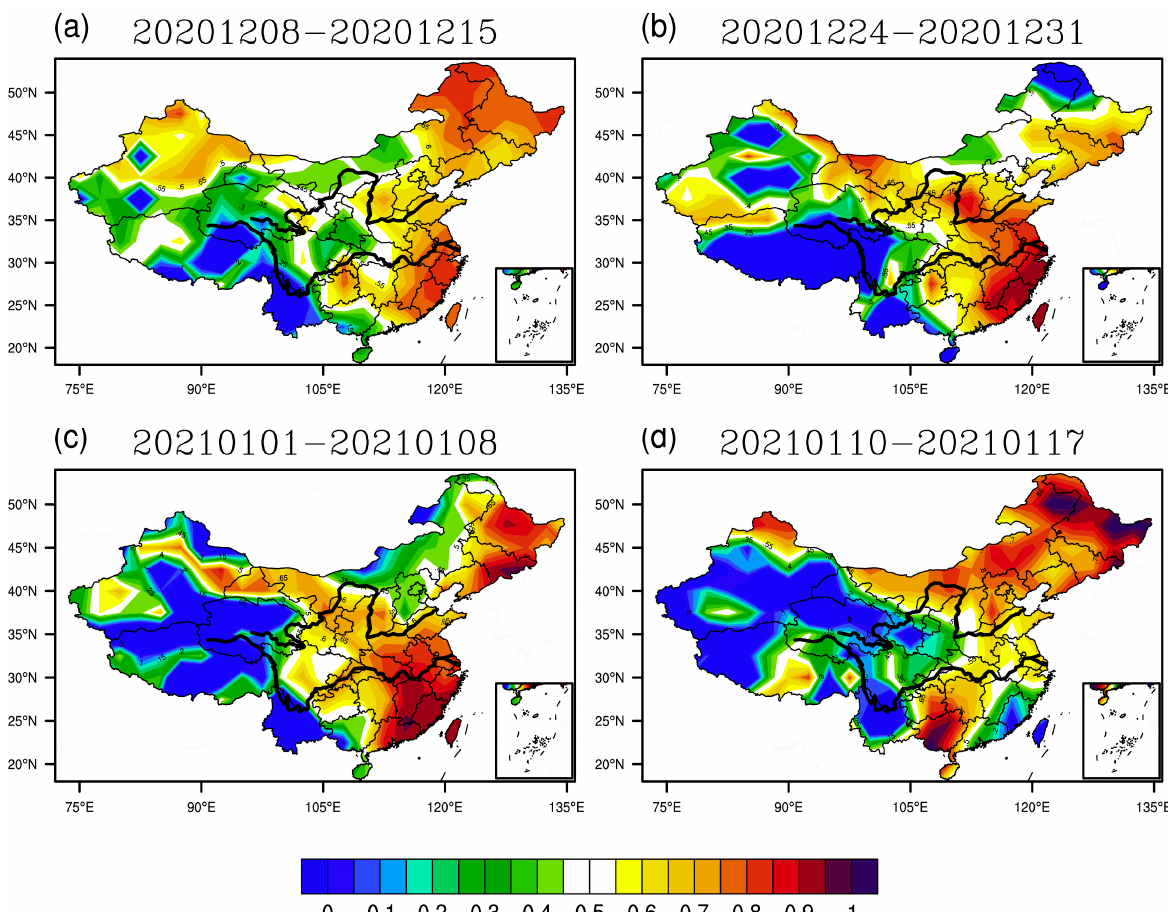
Figure 7. The correlation coe ffi cient of CMA-GEPS in forecasting the temperature of 2 m ahead for fi ve days and observations during the ( a ) “1212”, ( b ) “1228”, ( c ) “0105”, and ( d ) “0114” cold wave events.